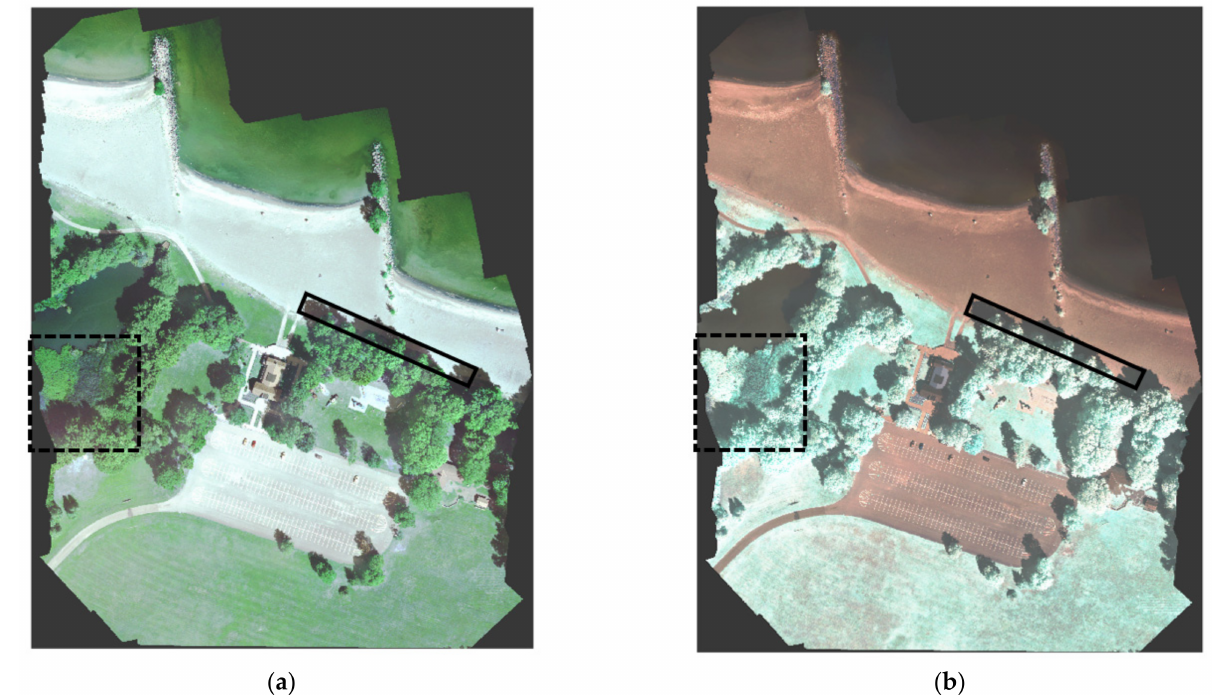
Figure 7. ( a ) RGB image (bands 3, 2, and 1) of the RIT-18 test image; ( b ) pseudo color image of bands 4–6 of the RIT-18 test image.